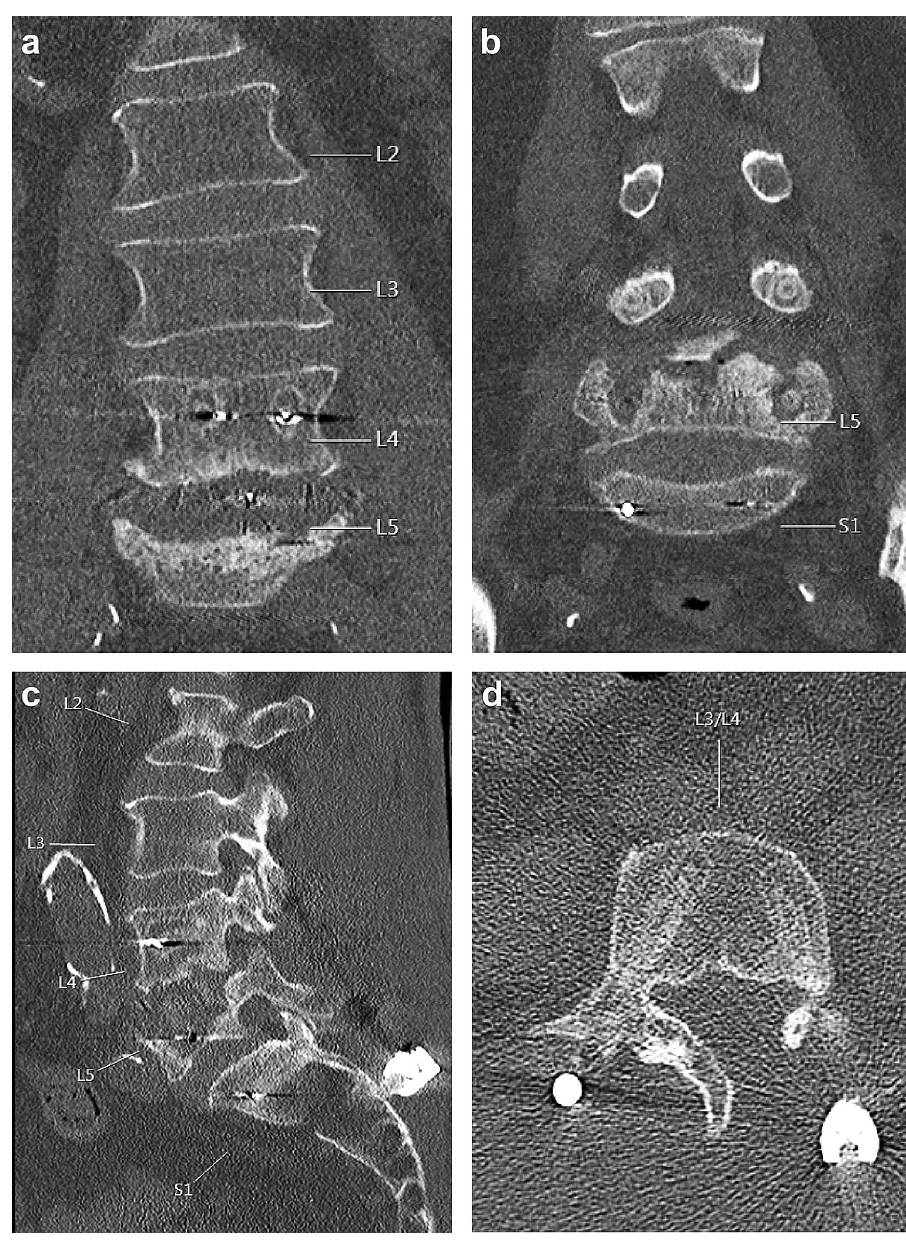
Figure 2. Example 1 of CT-imaging of screw loosening after CFR-PEEK instrumentation. CT-scan of a case of screw loosening of the CFR-PEEK group 128 days post-surgery. CFR-PEEK instrumentation was performed on L4–5–S1–S2 and involved the affected vertebrae on L4/5. L4 and L5 pedicle screws show a halo as a sign for loosening. ( a , b ) coronal plane; ( c ) sagittal plane, ( d ) axial plane of